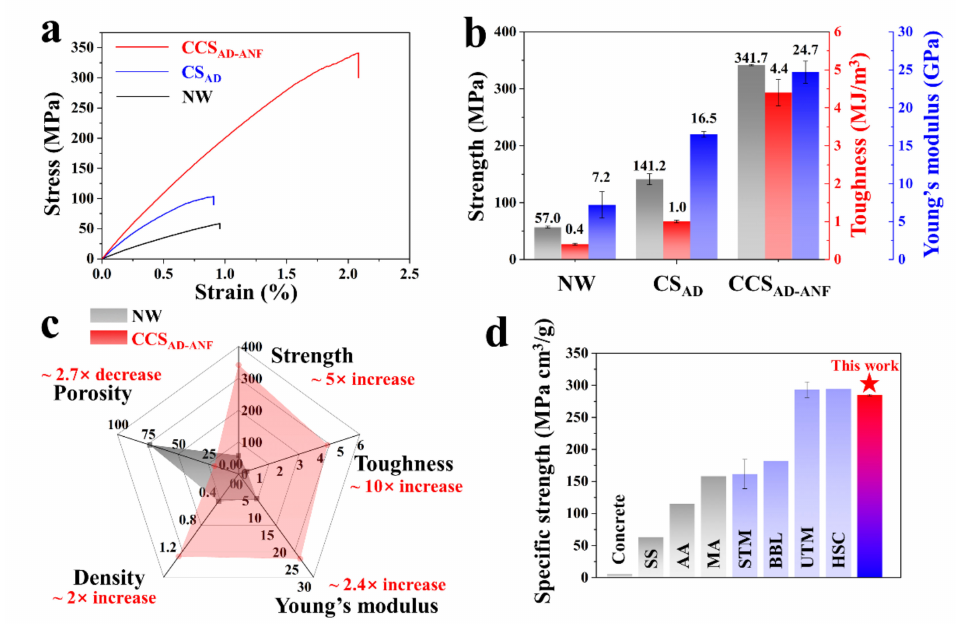
Figure 4. Mechanical performance of NW, CS AD and CCS AD-ANF . ( a ) Tensile stress-strain curves for NW, CS AD and CCS AD-ANF . ( b ) Tensile strength, toughness and Young’s modulus values derived from the tensile stress-strain curves of NW, CS AD and CCS AD-ANF . ( c ) Comparison of the physical and mechanical properties of NW and CCS AD-ANF . ( d ) Comparison of the specific strength of CCS AD-ANF , concrete, stainless steel (304, SS), aluminum alloy (6061-T6, AA), magnesium alloy (MA), strong and tough material (STM), bio-based laminate (BBL), ultrastrong and tough material (UTM) and high-strength composite